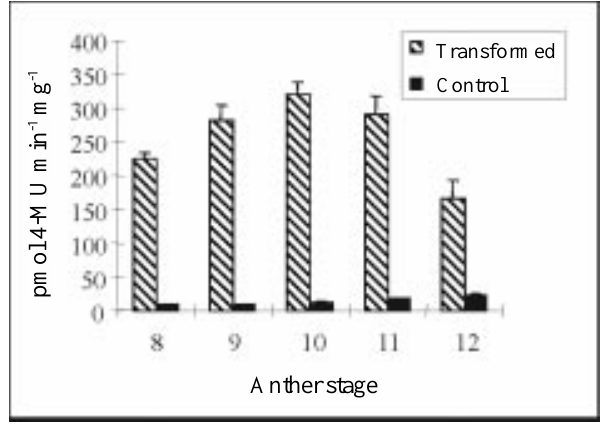
Figure 4 - Temporal pattern of G9- GUS expression, measured by the MUG fluorogenic assay in tobacco anthers at stages 8-12. The control is a nontransformed Nicotiana tabacum ‘Havana 425’ plant. The product of GUS enzyme activity (MU) was quantified with a fluorimeter with excita- tion at 365 nm and emission at 455 nm. The results are the average of at least three independent measurements.